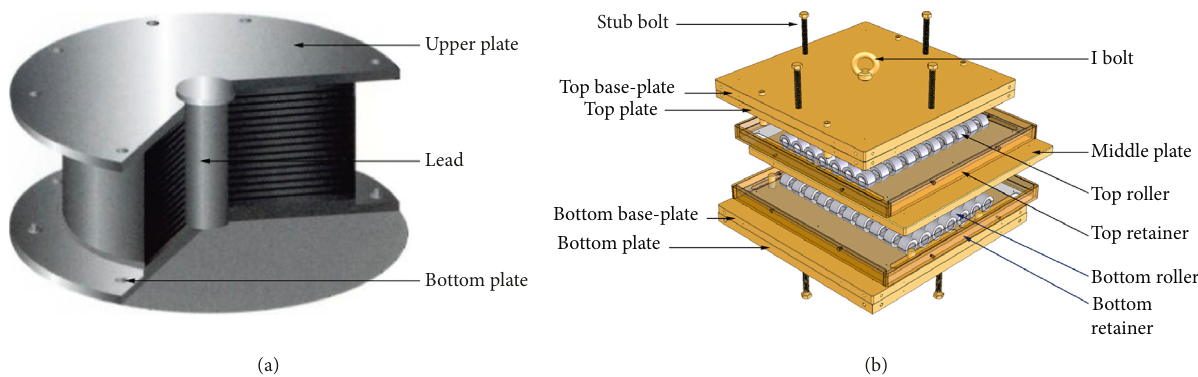
Figure 6: Isolation devices. (a) Lead rubber bearing. (b) Roller bearing.